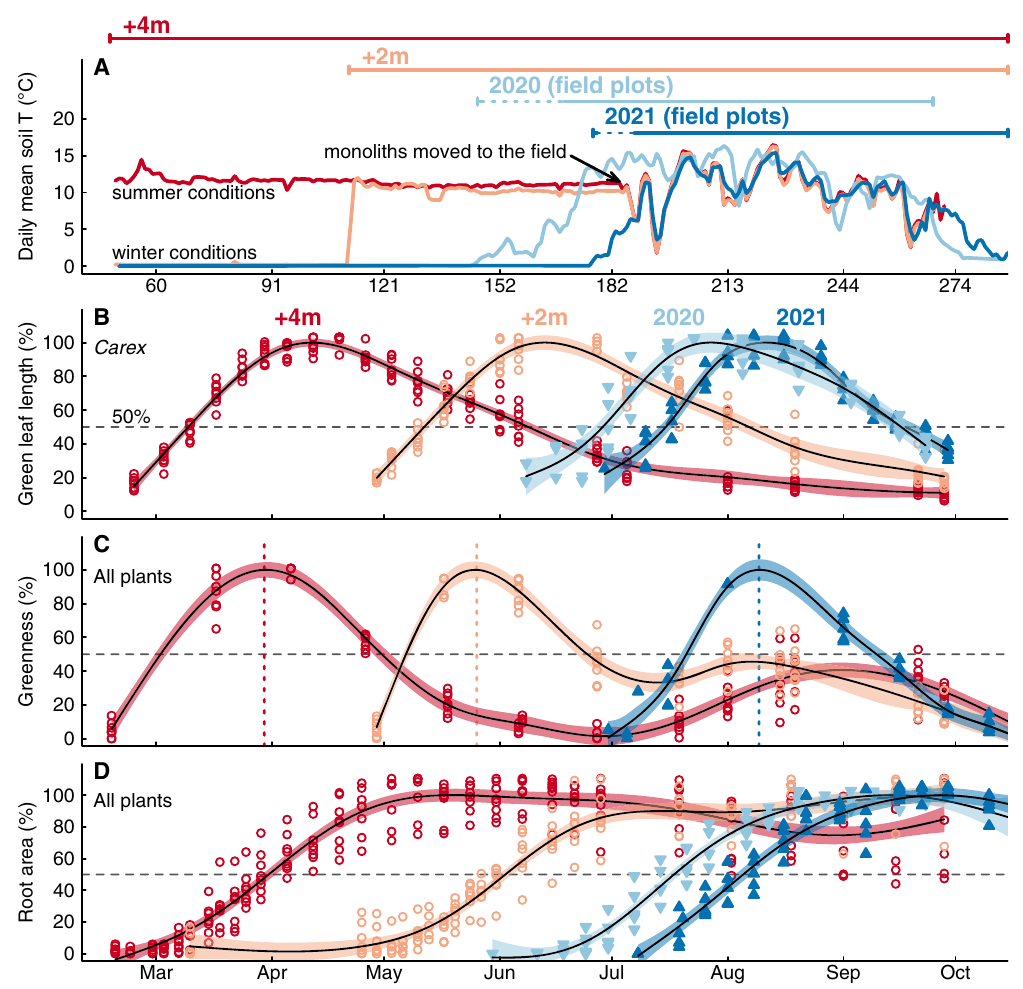
Fig. 2 | Impact of growing season length (GSL) on the timing of growth and senescence. Soil temperature and growth parameters with different growing sea- sonlength,experimentallyadvancedinclimatechambers(+4m,+2m,in2021)and comparedto fi eldplots(2020,2021).Dayoftheyearisspeci fi edforthe fi rstdayof each month below the x axis of A . GSL is indicated for each group at the top of A (dotted line during snowmelt). All growth data were scaled to 0 – 100% to ease